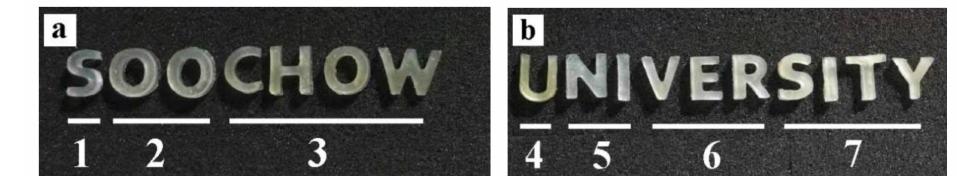
Figure 2. The 3D composite scaffold based on silk protein. The number of SF scaffolds and SP composite scaffolds printed with SP ink are shown in ( a ): (1) G-SF, (2) G-SF/WS (10%), (3) G-SF/WS (20%); ( b ): (4) G-SF/WS (30%), (5) G-SF/ILS (10%), (6) G-SF/ILS (20%), and (7) G-SF/ILS (30%).